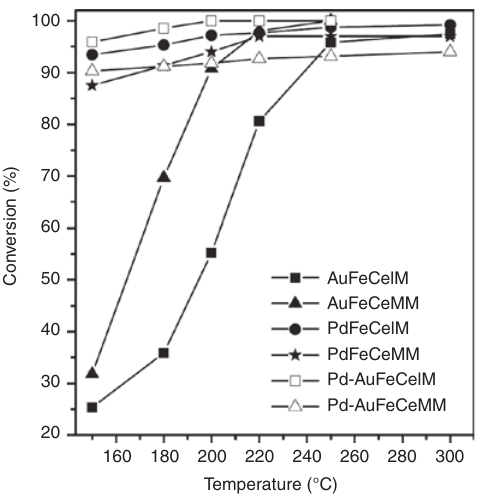
Figure 15: The conversion of benzene over Au, Pd and Pd-Au cata- lysts on Fe-modified ceria. Reproduced from [58] with permission from Elsevier BV.